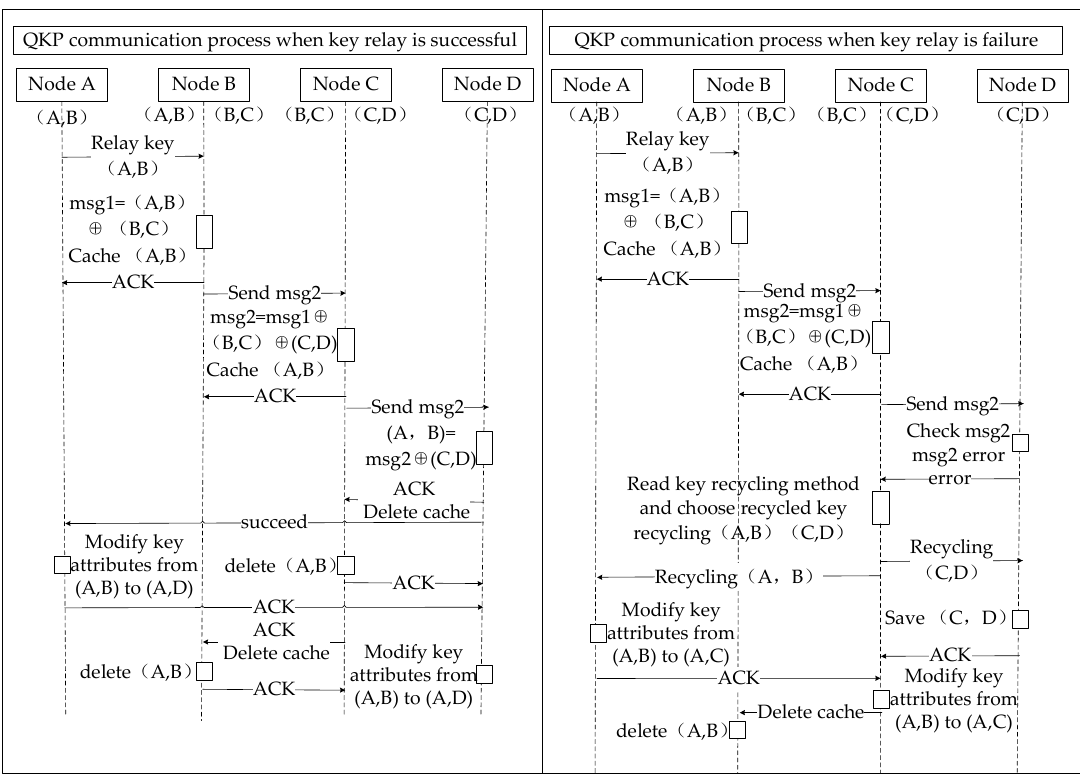
Figure 5. Quantum key pool (QKP) communication mechanism in two cases: relay success and failure.